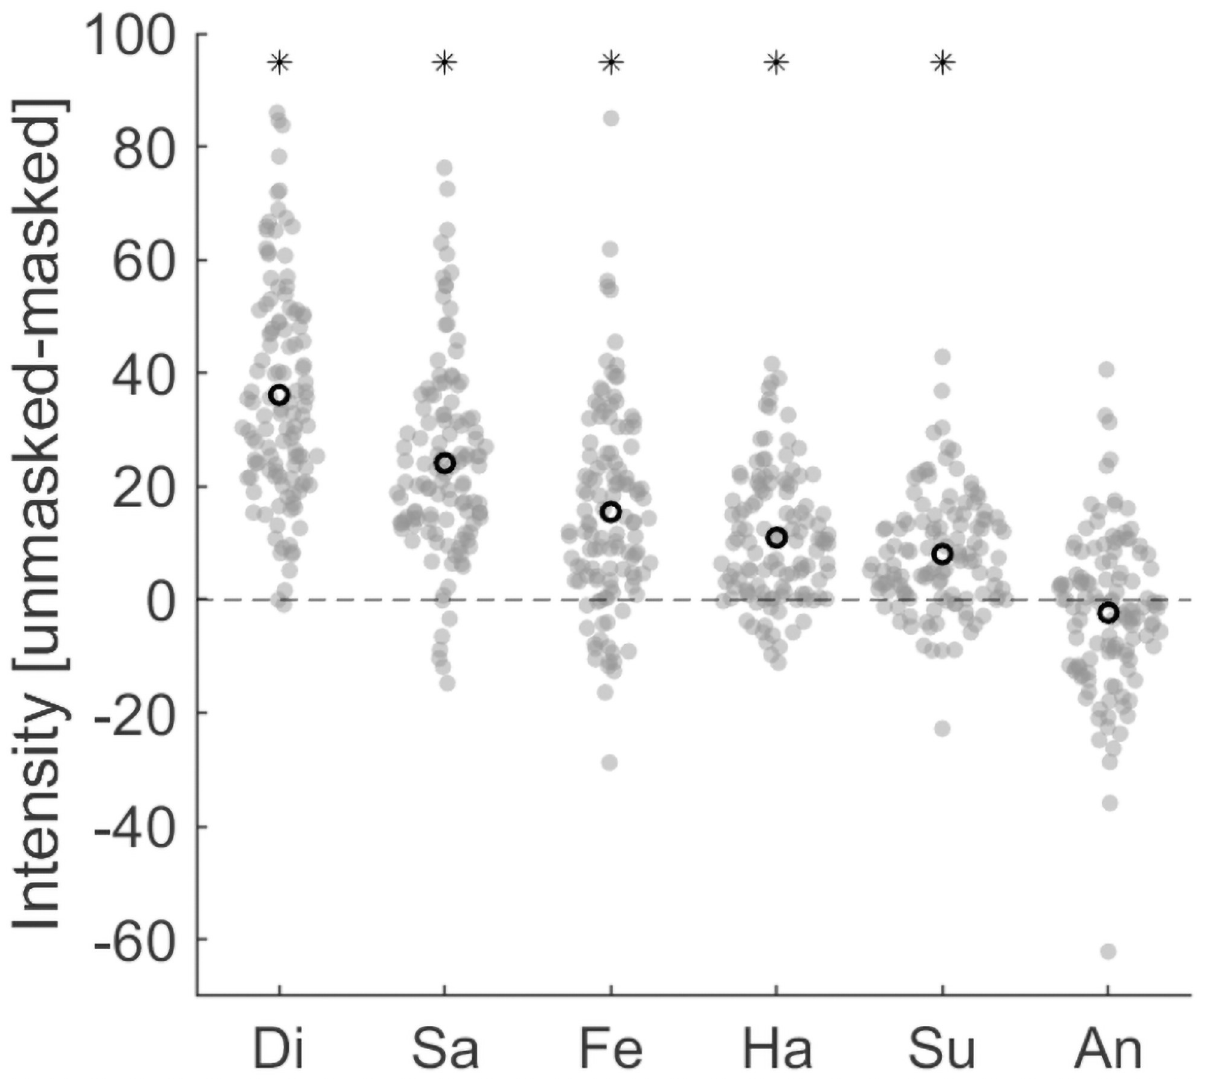
Fig 2. Differences in intensity ratings of intended emotions between unmasked and masked faces. Black hollow circles show the means. Positive values indicate higher ratings for unmasked faces. Emotions are sorted from highest to lowest based on the mean difference. Asterisks show significant contrasts between unmasked and masked ratings after FDR correction for six comparisons. Ha: happiness, Sa: sadness, An: anger, Fe: fear, Di: disgust, Su: surprise.